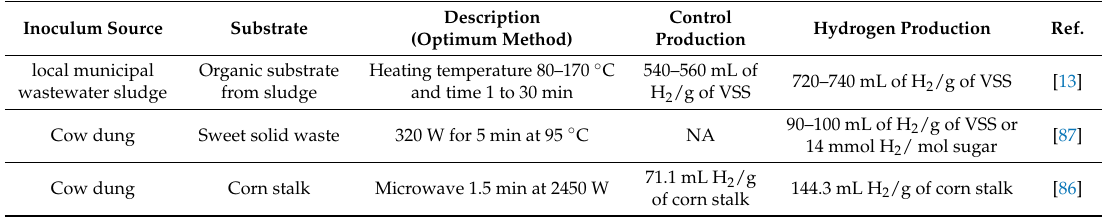
Table 3. Hydrogen yield by mixed culture using microwave